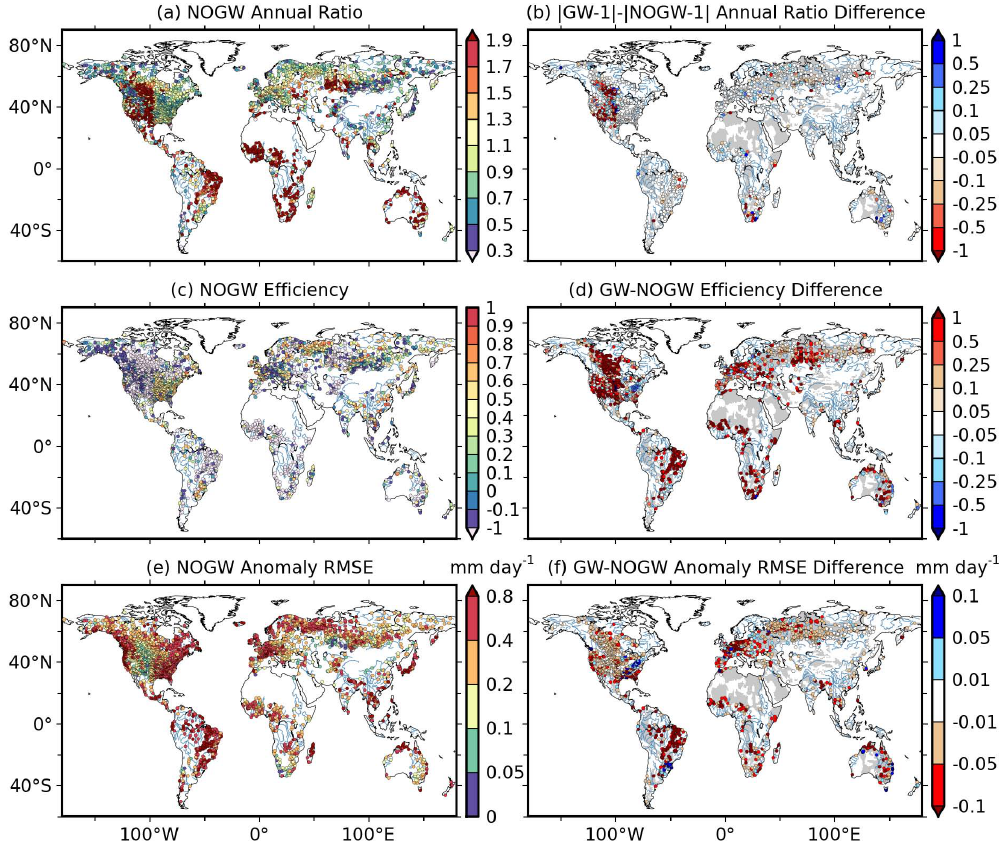
Fig. 3. Evaluation of the simulated monthly discharges with (GW) and without (NOGW) the groundwater scheme. (a) The NOGW annual ratio and (c) efficiency in terms of absolute values as well as (e) the RMSE in terms of monthly anomalies are given at each of the 3500 gauging stations. (b, d, f) The difference with the GW scores is also shown at each of the 1900 gauging stations potentially impacted by the aquifers. The gray-shaded zones in (b, d, f) represent the TRIP aquifer